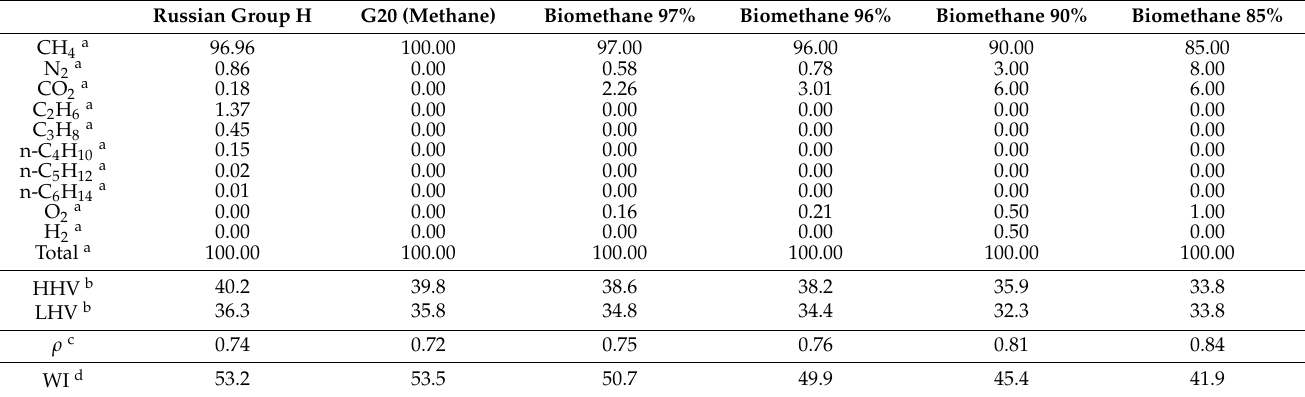
Table 4. Gas composition and combustion parameters of fossil NG and renewable